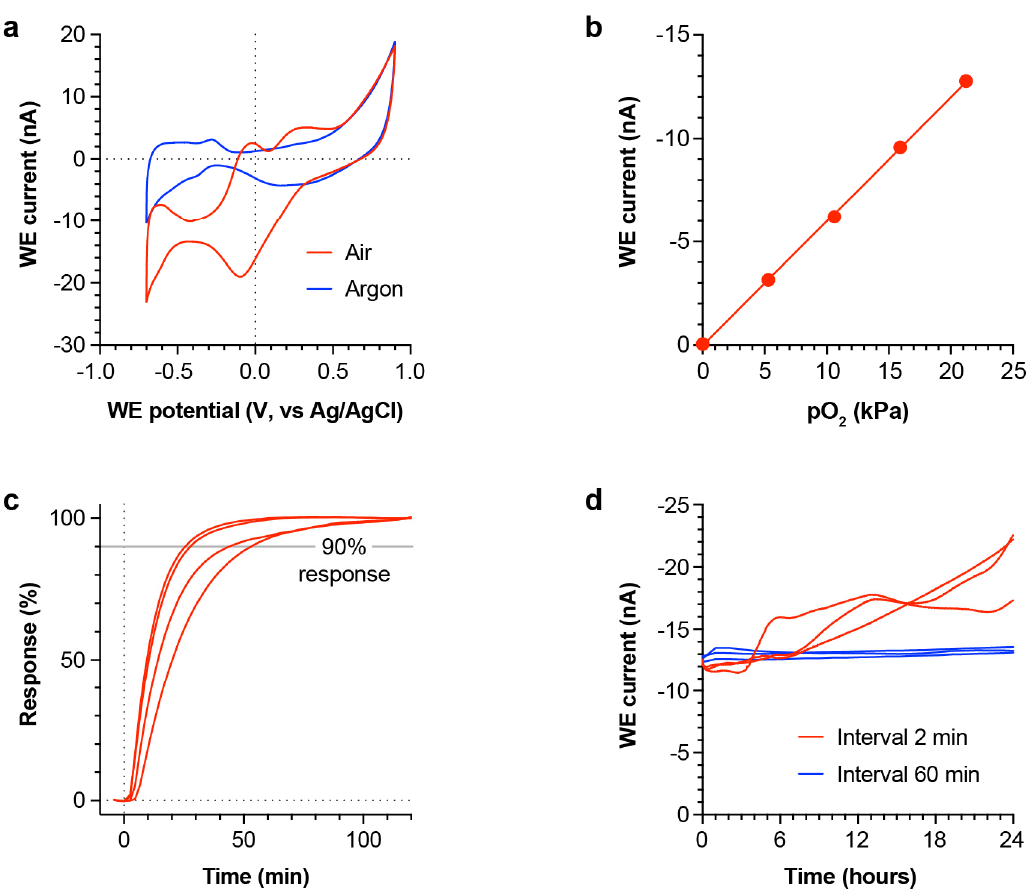
Figure 2. Bench characterisation of sensor performance. ( a ): Typical CV scans of sensor in PBS saturated with air (red) and PBS degassed by sparging with argon (blue). Similar results were obtained from four sensors. ( b ): Mean steady-state WE current at − 0.5 V measured over a range of oxygen partial pressures in PBS ( n = 3 sensors). ( c ): Sensor response when moved at t = 0 min from argon-sparged PBS (negligible oxygen) to an air-saturated PBS solution. Steady-state currents were normalised between 0% and 100% response for comparison. Grey line at 90% response indicates the threshold for determining response time. Individual responses from four sensors are shown (red lines). ( d ): Mean steady-state current at − 0.5 V in air-saturated PBS over 24 h. Sensor recordings were performed at intervals of either 2 min (red) or 60 min (blue) ( n = 3 sensors/condition).